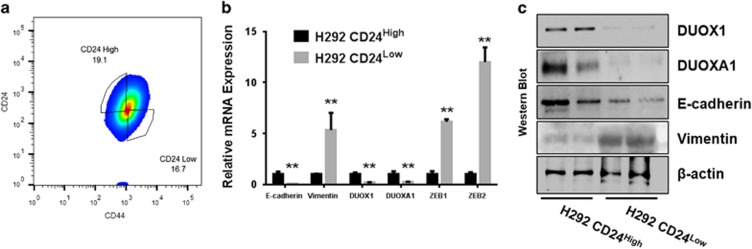
EMT features and loss of DUOX1 in the H292 CD24low sub-population. (a) FACS gating strategy displaying H292 cell sub-populations were sorted based on their expression of surface antigen CD24/CD44. (b) Quantitative real-time PCR and western blot (c) results displaying CD24low H292 sub-populations display features of EMT and marked DUOX1 suppression. *P<0.05 and **P<0.01 were calculated by Student's t-test.